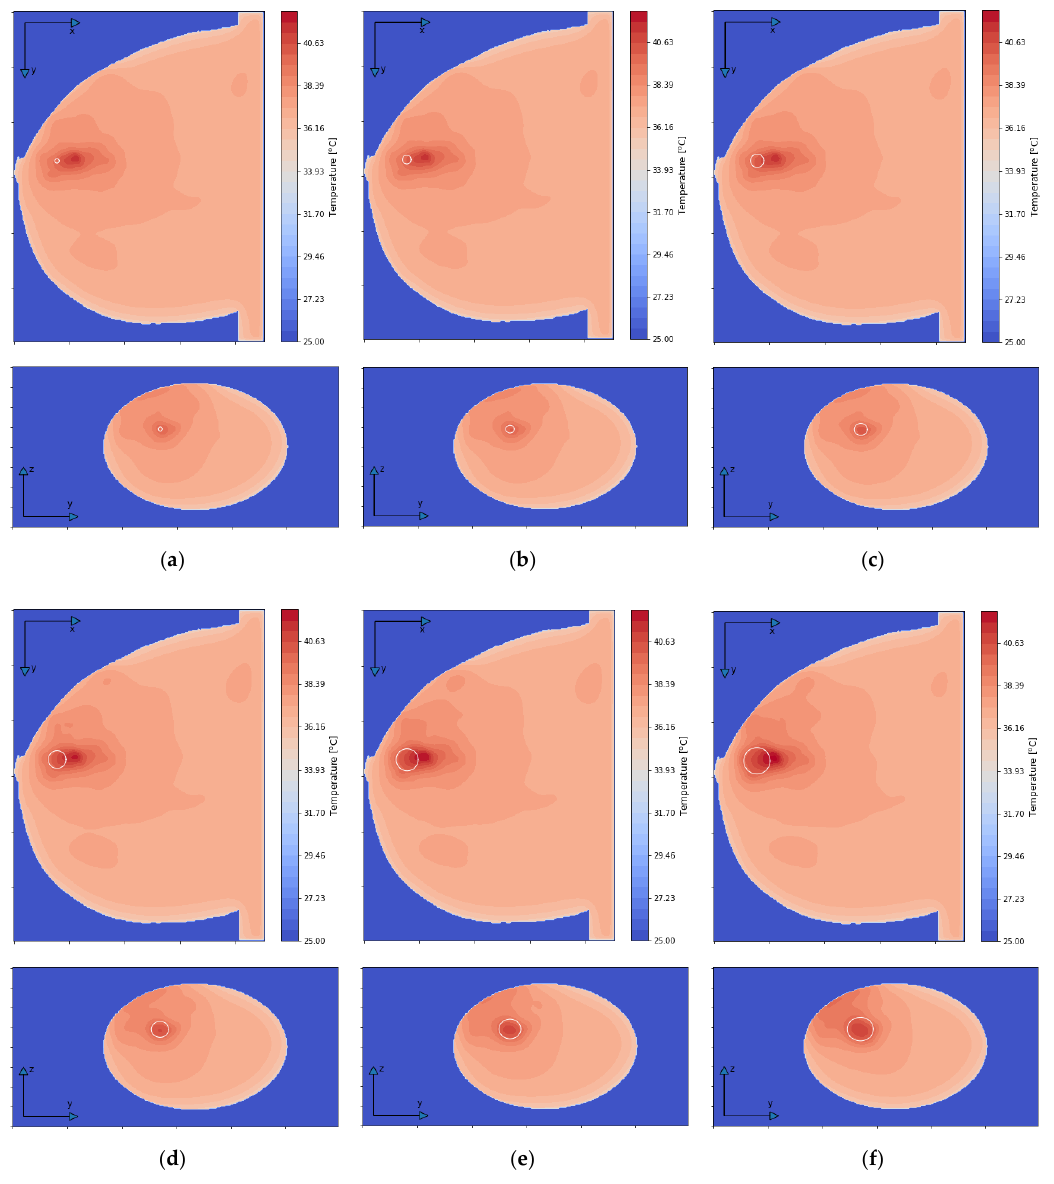
Figure 8. The temperature distributions in the xy and zy planes for various tumor radii: ( a ) r = 2 mm; ( b ) r = 4 mm; ( c ) r = 6 mm; ( d ) r = 8 mm; ( e ) r = 10 mm; ( f ) r = 12 mm—derived from the eight-dipole antenna array after the optimization procedure (sum P i = 8W).